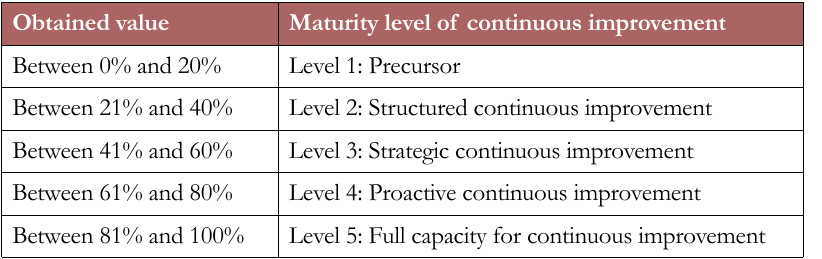
Table 2. Improvement maturity levels of the Bessant et al. (2001) model